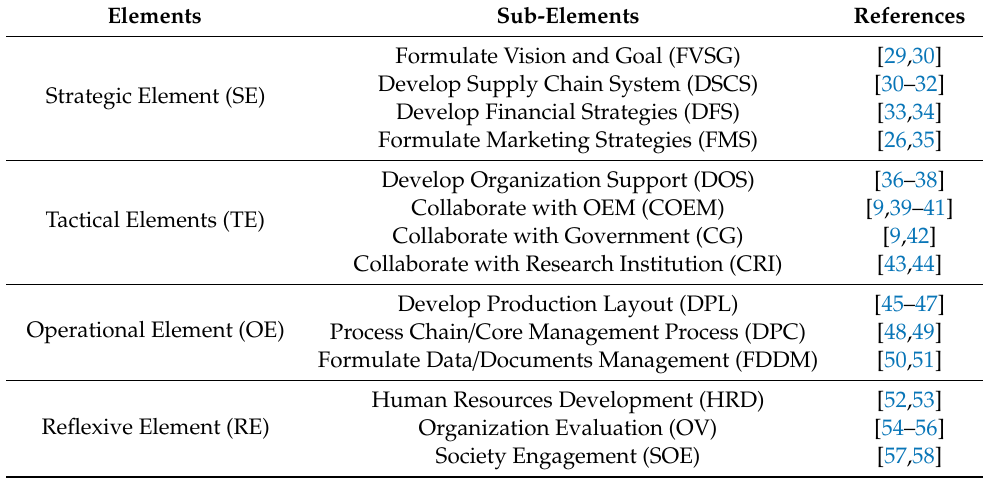
Table 1. Classification of transitional decision-making framework (TDMF)